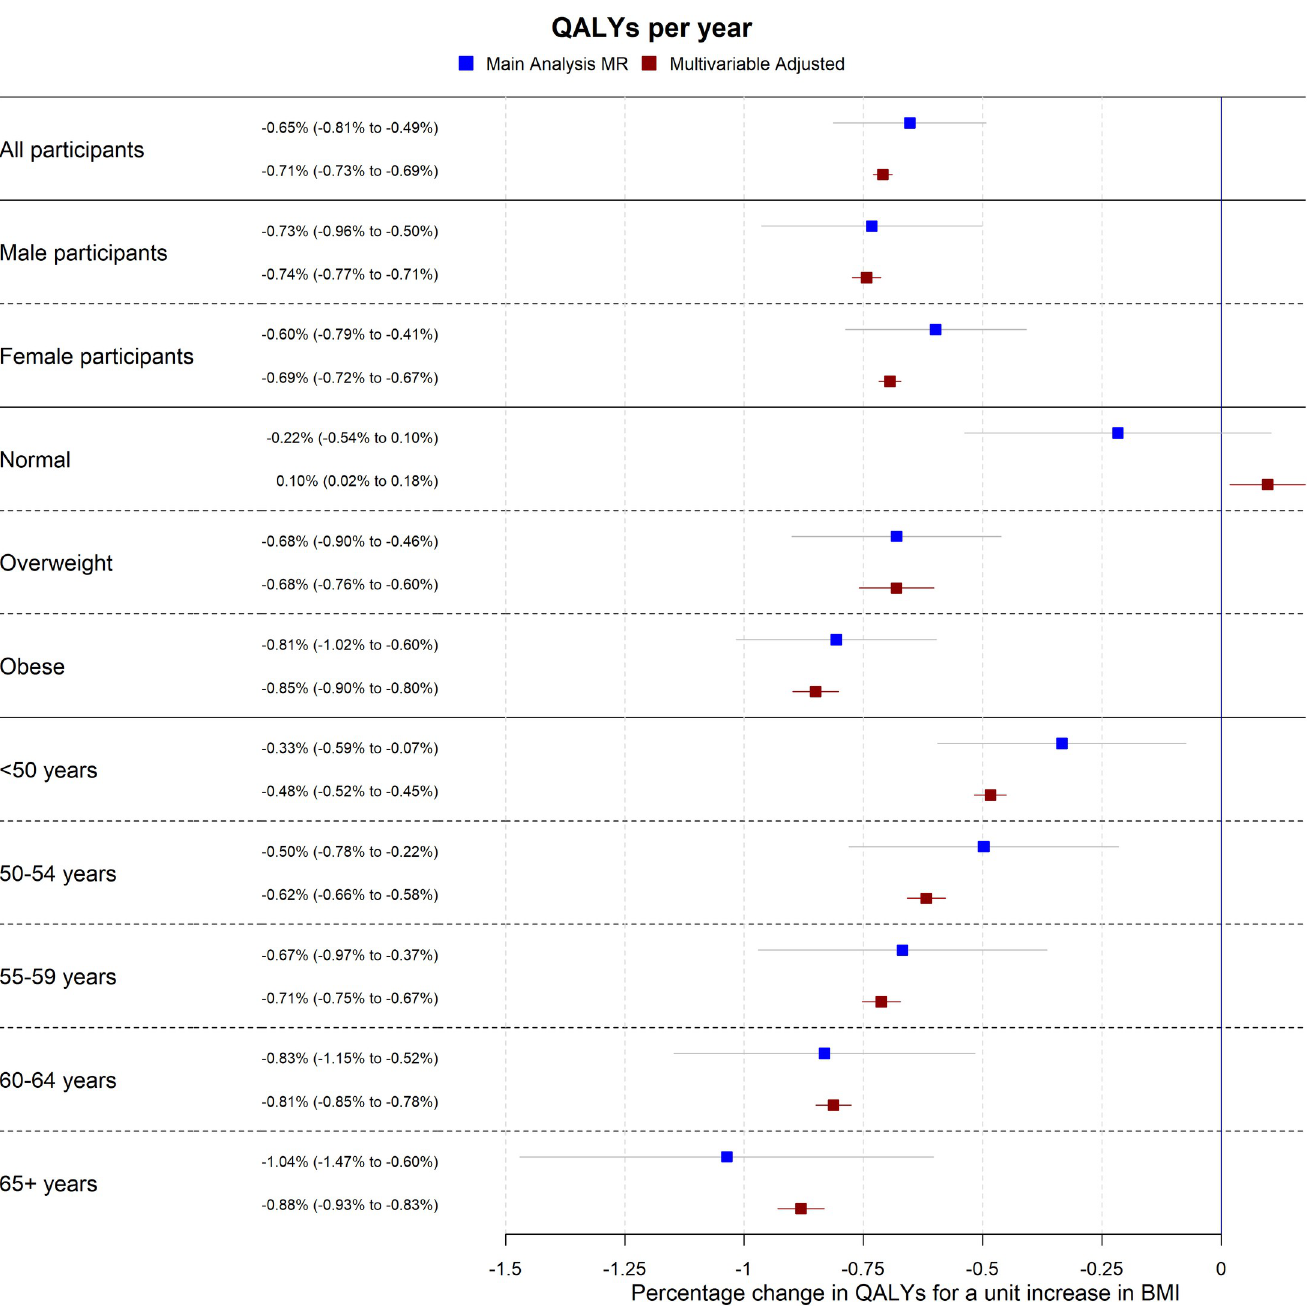
Fig 2. MR estimates for QALYs per year. Forest plot showing the estimated effect of a unit increase in BMI on average QALYs per year for the main MR, sex- specific, BMI categorical (where “Normal” is a BMI below 25 kg/m 2 , “Overweight” is a BMI between 25 kg/m 2 and 30 kg/m 2 , and “Obese” is a BMI of above 30 kg/ m 2 ) and age categorical analyses. Effect estimates are indicated by squares, 95% CIs by horizontal lines around the squares. Effect estimates are derived from the main imputation model (for all and sex-specific estimates) or the categorical imputation model (for BMI and age category–specific estimates). Both analyses adjusted for age, sex, recruitment centre, and 40 genetic principal components. BMI, body mass index; CI, confidence interval; MR, mendelian randomisation; QALY, quality- adjusted life